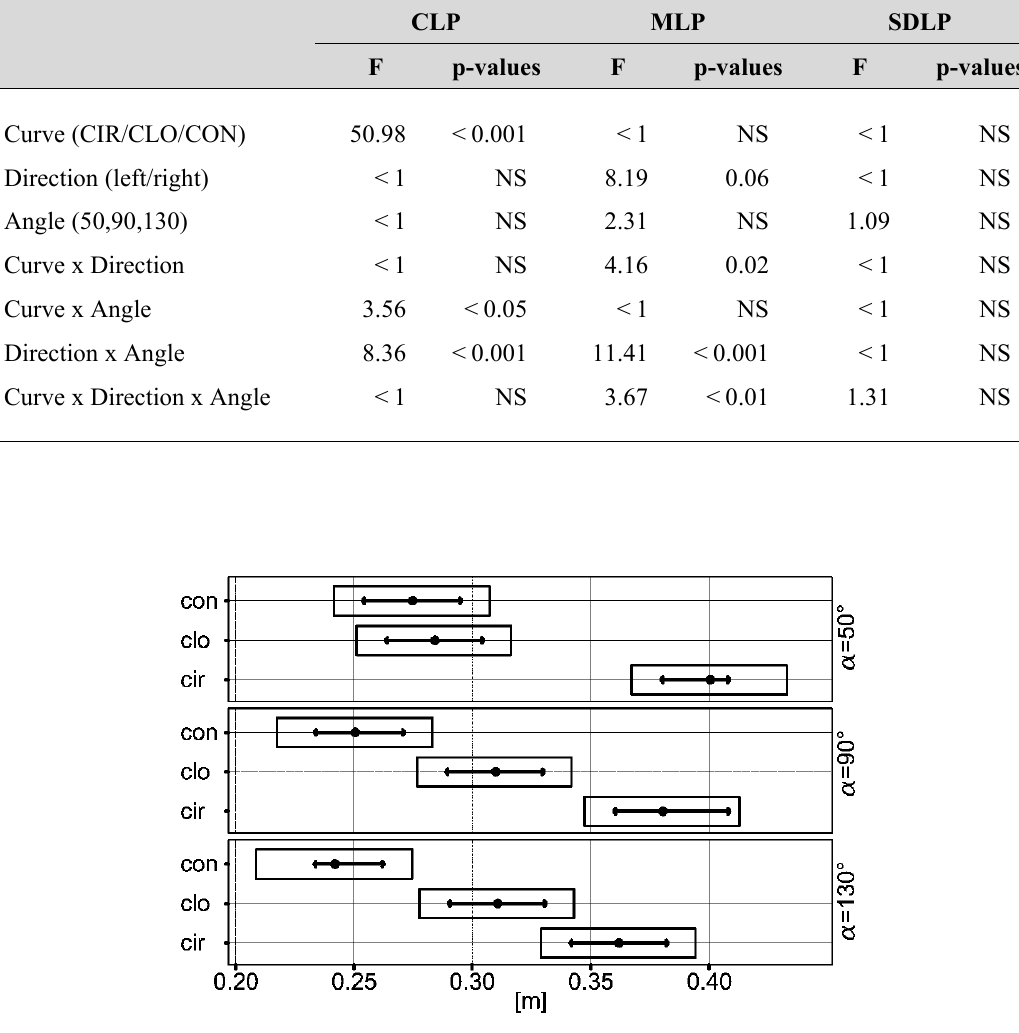
Figure 5 Estimated marginal means of CLP with ‘ Curve ’ and ‘Angle (α)’ predictors. In this figure the di- rection of the curve is not reported because no significant differences were found for direction.